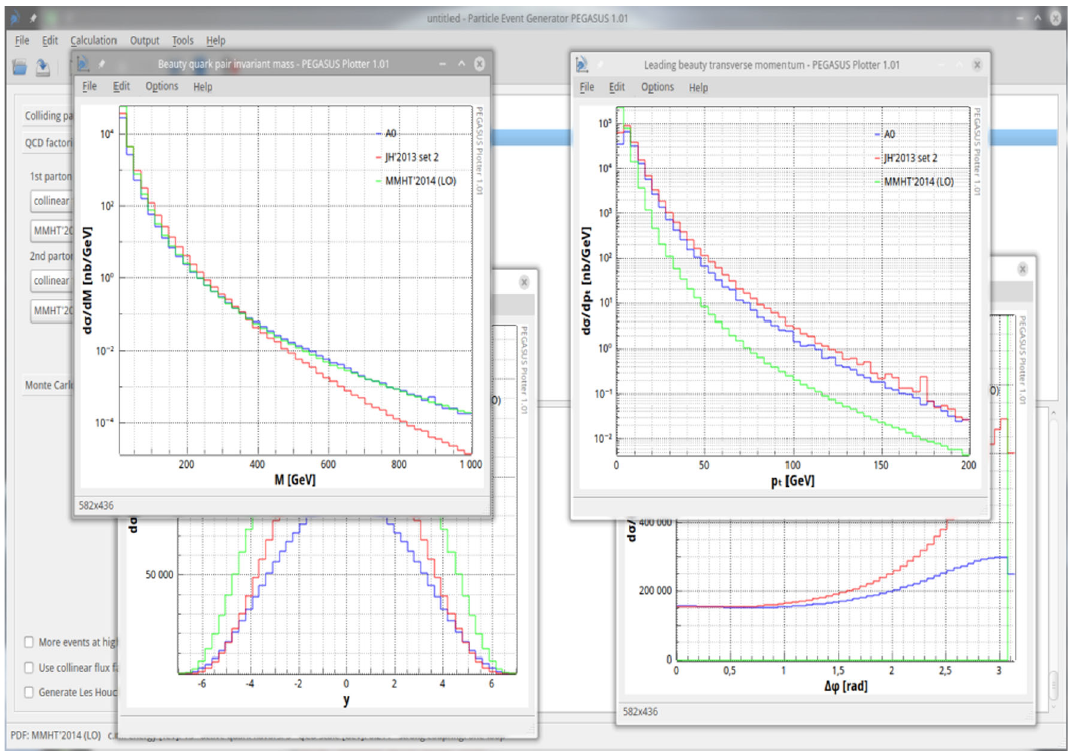
√ s = 13 TeV. No kinematical cuts are